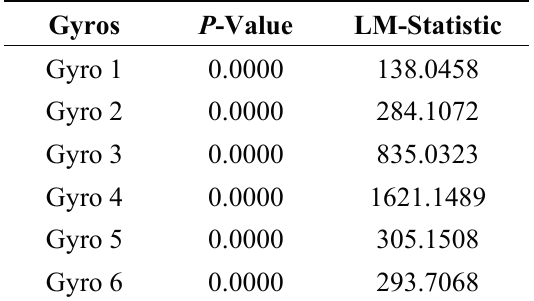
Table 1. Test results of Autoregressive Conditional Heteroskedasticity (ARCH) effect. Gyros P